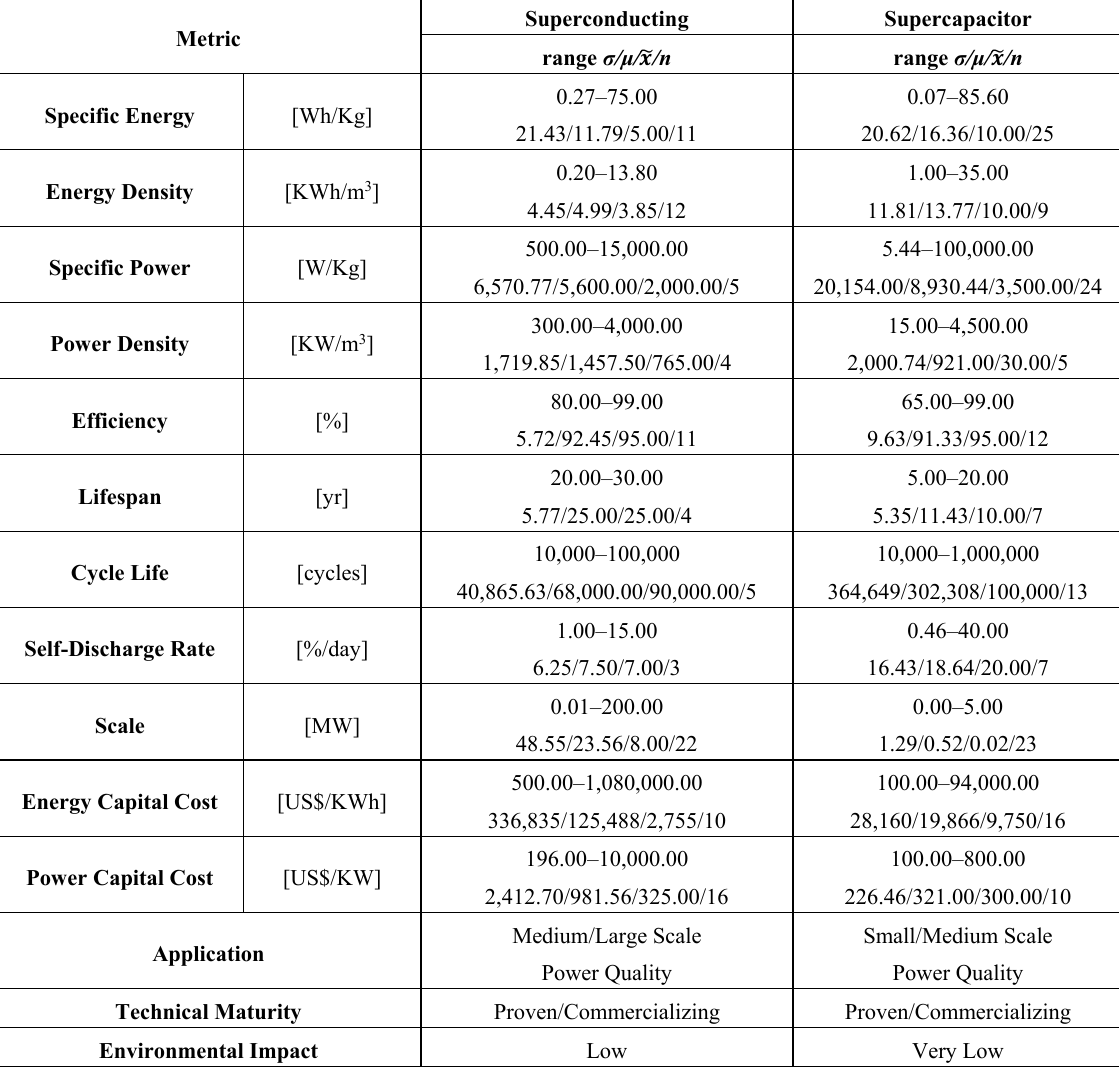
Table 9. Comparing electromagnetic storage based on fourteen different metrics. Data obtained or calculated from multiple sources